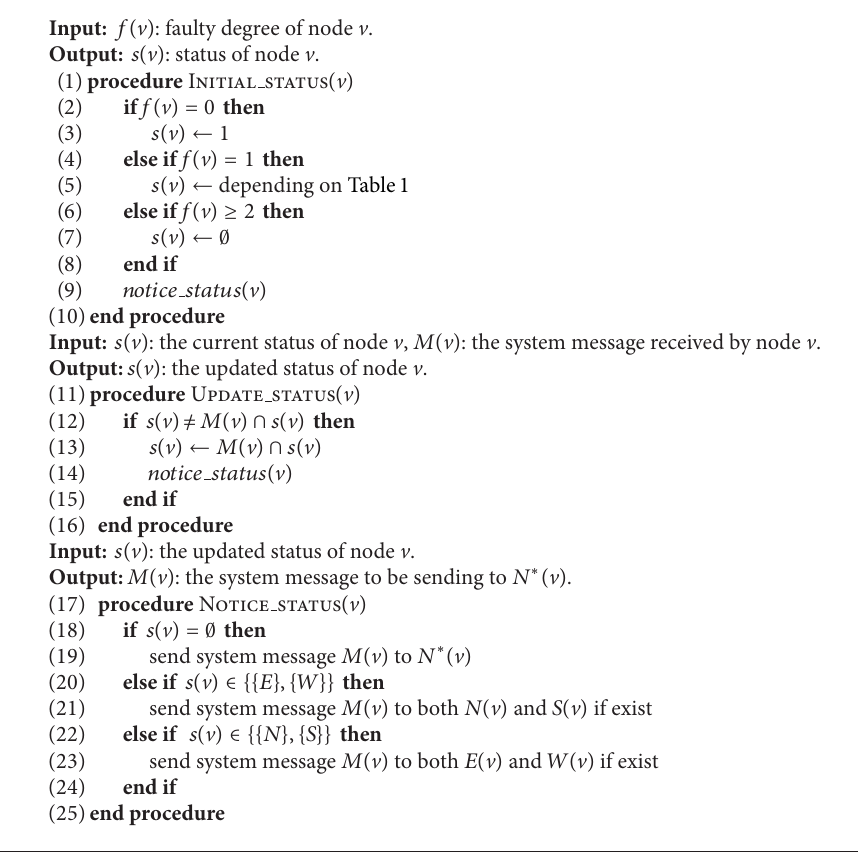
Algorithm 1: Let V be any node in the two-dimensional mesh, let 𝑓( V ) be the faulty degree, let 𝑠( V ) be the status, and let 𝑀( V ) be the content of received system message.